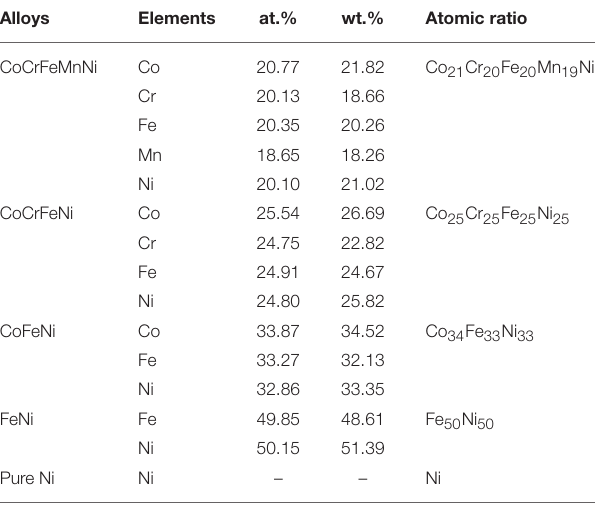
TABLE 1 | Composition of the alloys used in this